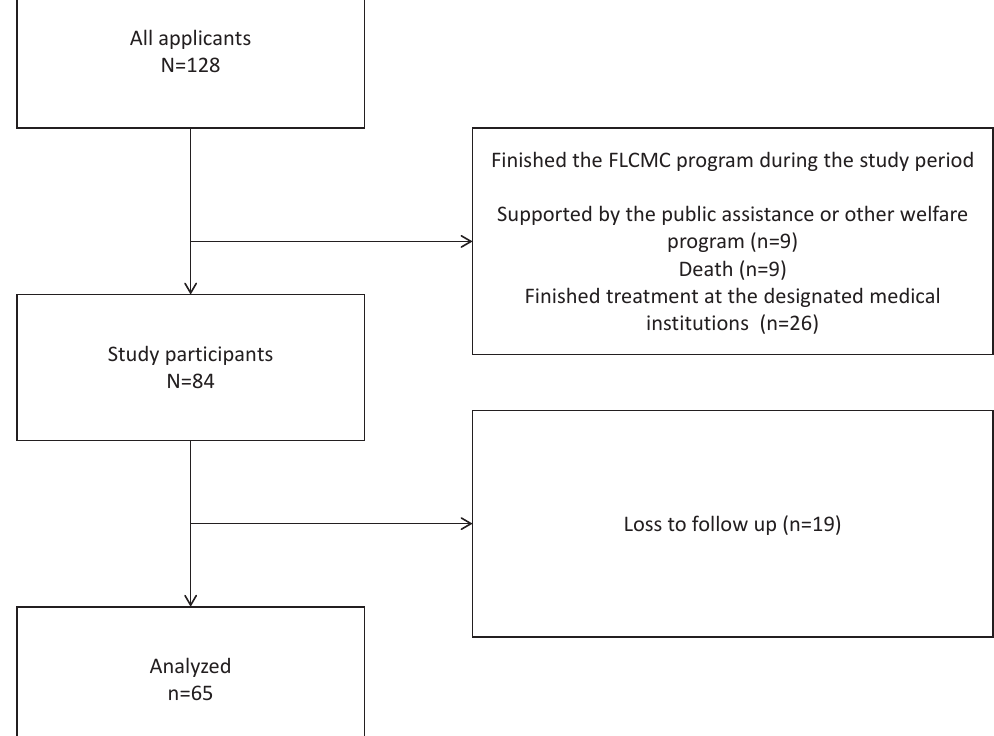
Figure 1. Study fl ow diagram. FLCMC, Free / Low-Cost Medical Care